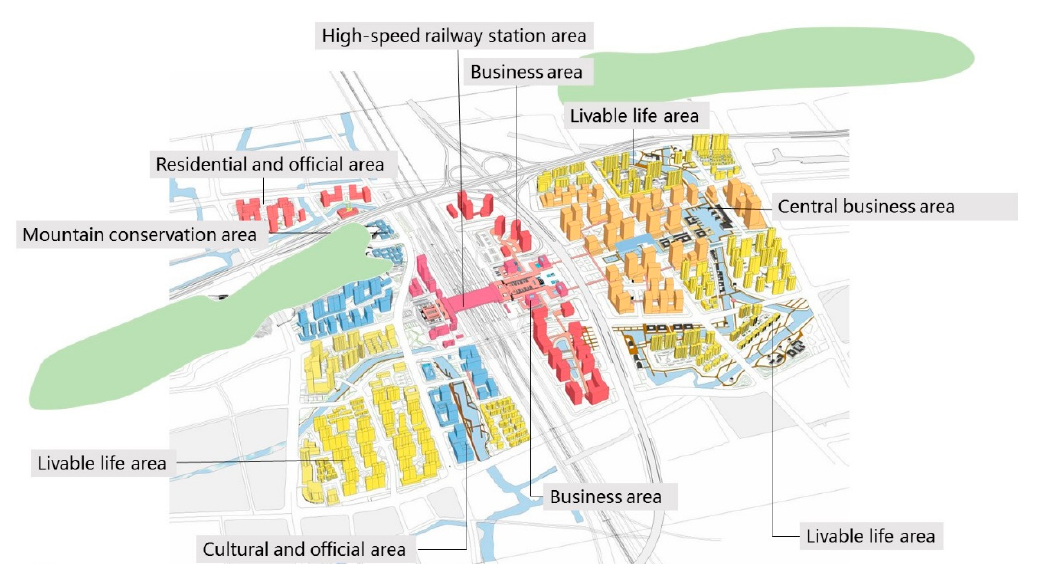
Figure 3. Functional area of Hangzhou South Station.